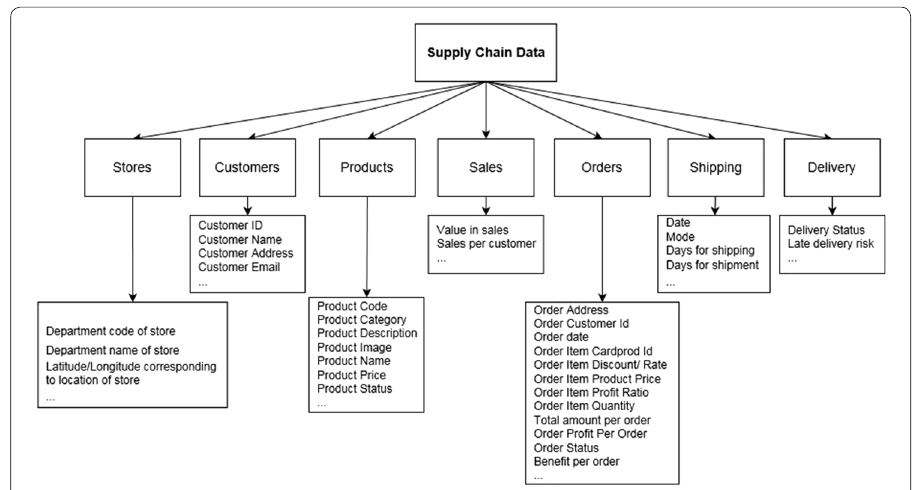
Fig. 1 Taxonomy of supply chain